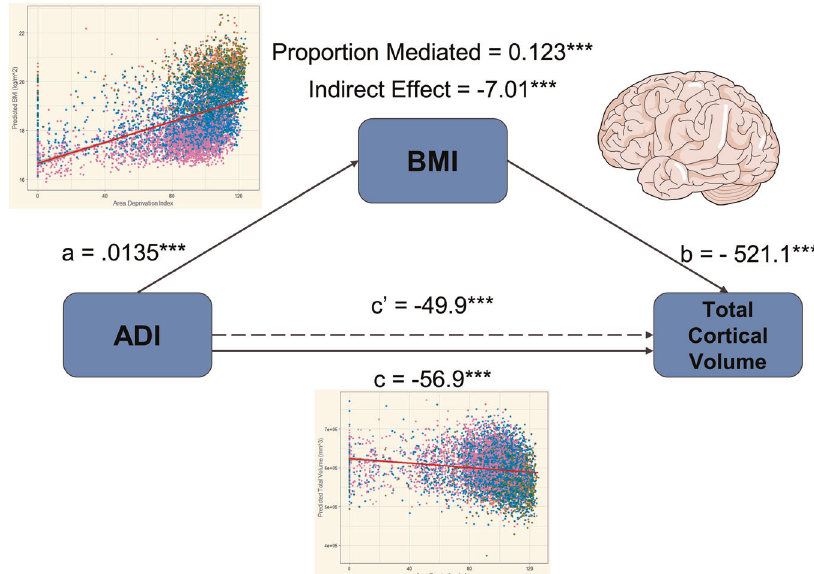
Fig. 3 Mediation model demonstrating the signi fi cant indirect effect of BMI in the relationship between ADI and total cortical volume. Reported values of a , b , and c are regression coef fi cients for each path. The indirect effect is the product of paths a and b and is described as the amount of mediation attributed to BMI. The dashed line corresponding to c ′ indicates the reduced direct effect of ADI on Cortical Volume when BMI is included as a mediator. Inset graphs are from Fig. 1 and are used to illustrate the relationships that must be established to conduct mediation analysis.